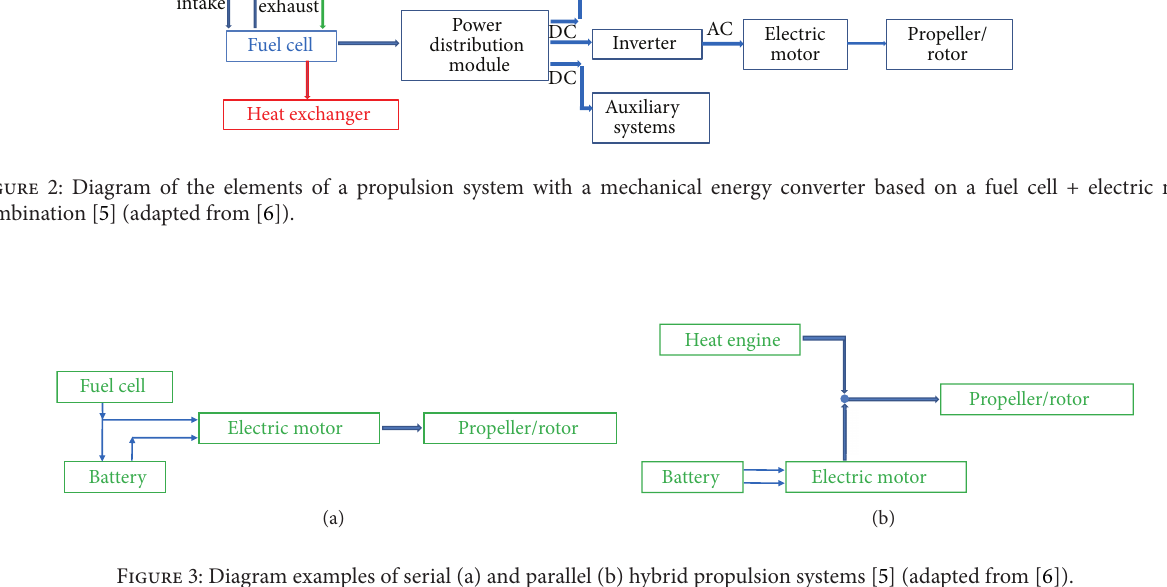
Figure 3: Diagram examples of serial (a) and parallel (b) hybrid propulsion systems [5] (adapted from